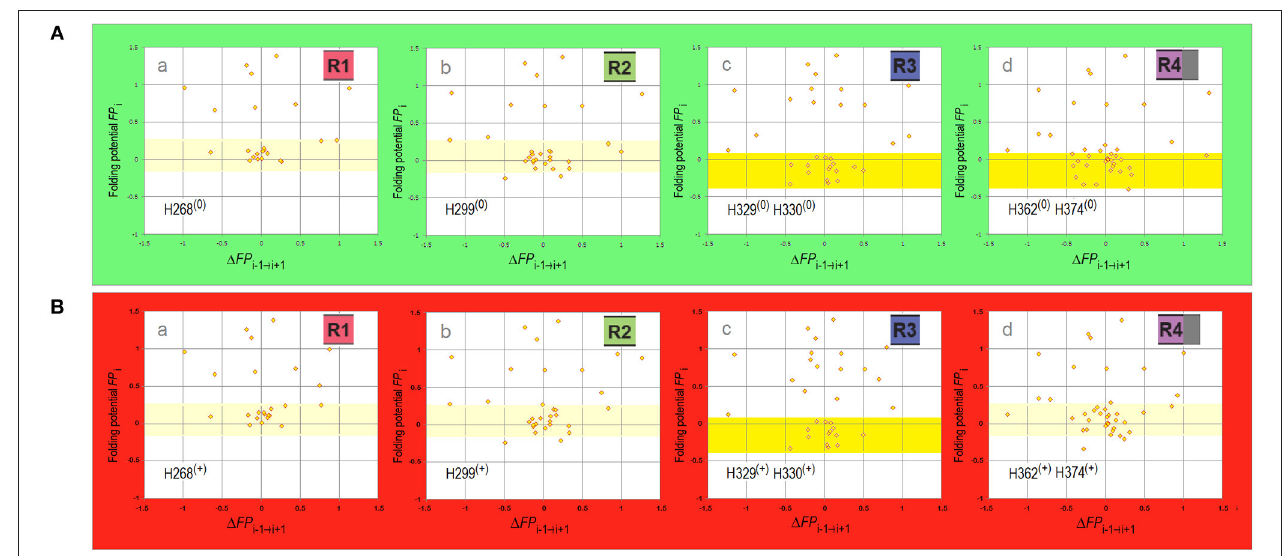
FIGURE 4 | Electronic configuration of the polypeptide backbone and secondary structure propensities of MTBD repeats. (A) The FP i vs. 1 FP i − 1 → i + 1 plots for MTBD repeats calculated with σ His = − 0.2917. The region of FP i color-coded pale yellow in R1 and R2 corresponds to the ambiguous “strand”/“helix” propensity in water, the region color-coded yellow in R3 and R4 corresponds to “C 5 strand” propensity in water. (a) Truncated R1, residues 252–274 (omitted the proline-rich segment 247 PVPMP 251 ); (b) R2, residues 275–305; (c) R3, residues 306–336; (d) Appended R4, residues 337–376 (appended 369 KKIETHKL 376 segment incorporated in some fibril cores). (B) The FP i vs. 1 FP i − 1 → i + 1 plots for MTBD repeats calculated with σ His + = 0.2584. The data plotted for the same sequences identified above in (A) (a–d), and the FP i regions color-coded as above, indicating water-bound ambiguous “strand”/“helix” propensity in R1, R2, and R4, and water-bound “C 5 strand” propensity in R3.